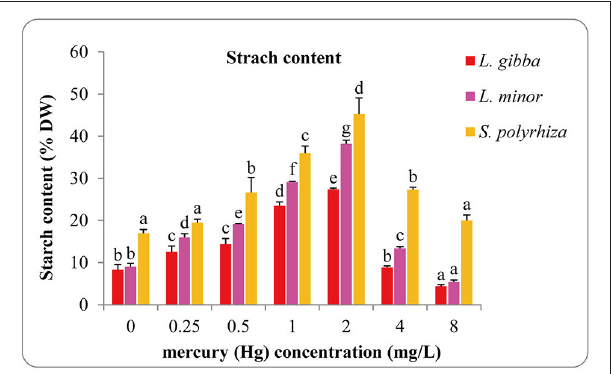
FIGURE 5 | Effects of different concentrations of Hg on starch content of three duckweed lines. The starch content was measured after 7 days and calculated based on the dry weight (DW). The letters (a, b, c, d, e, f) on the column graphs indicated Tukey tests analyses results among different Hg treatments in the same duckweed. The same letters indicated no significant differences and different letters indicated significant difference among treatments. Error bars indicated standard